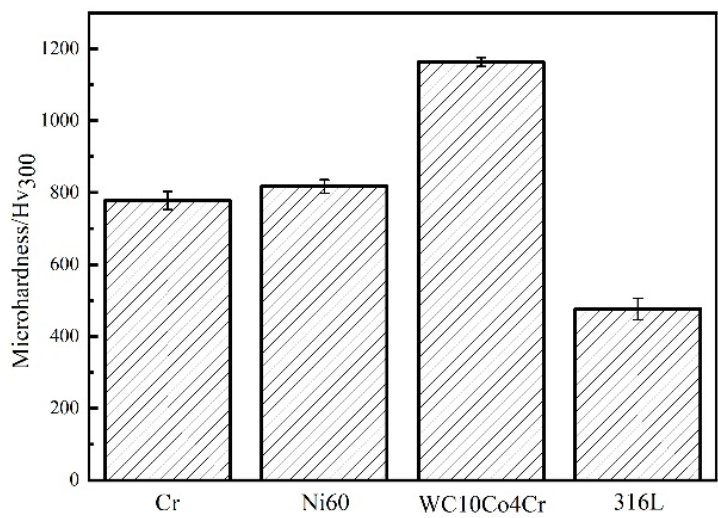
Figure 6. Microhardness of hard chrome plating and HVOF coatings.